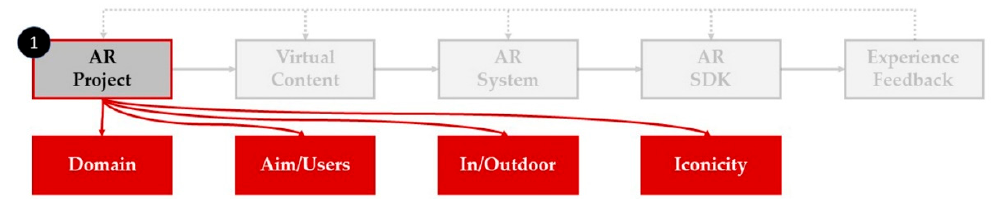
Figure 4. Block diagram of the main features of the AR system design.